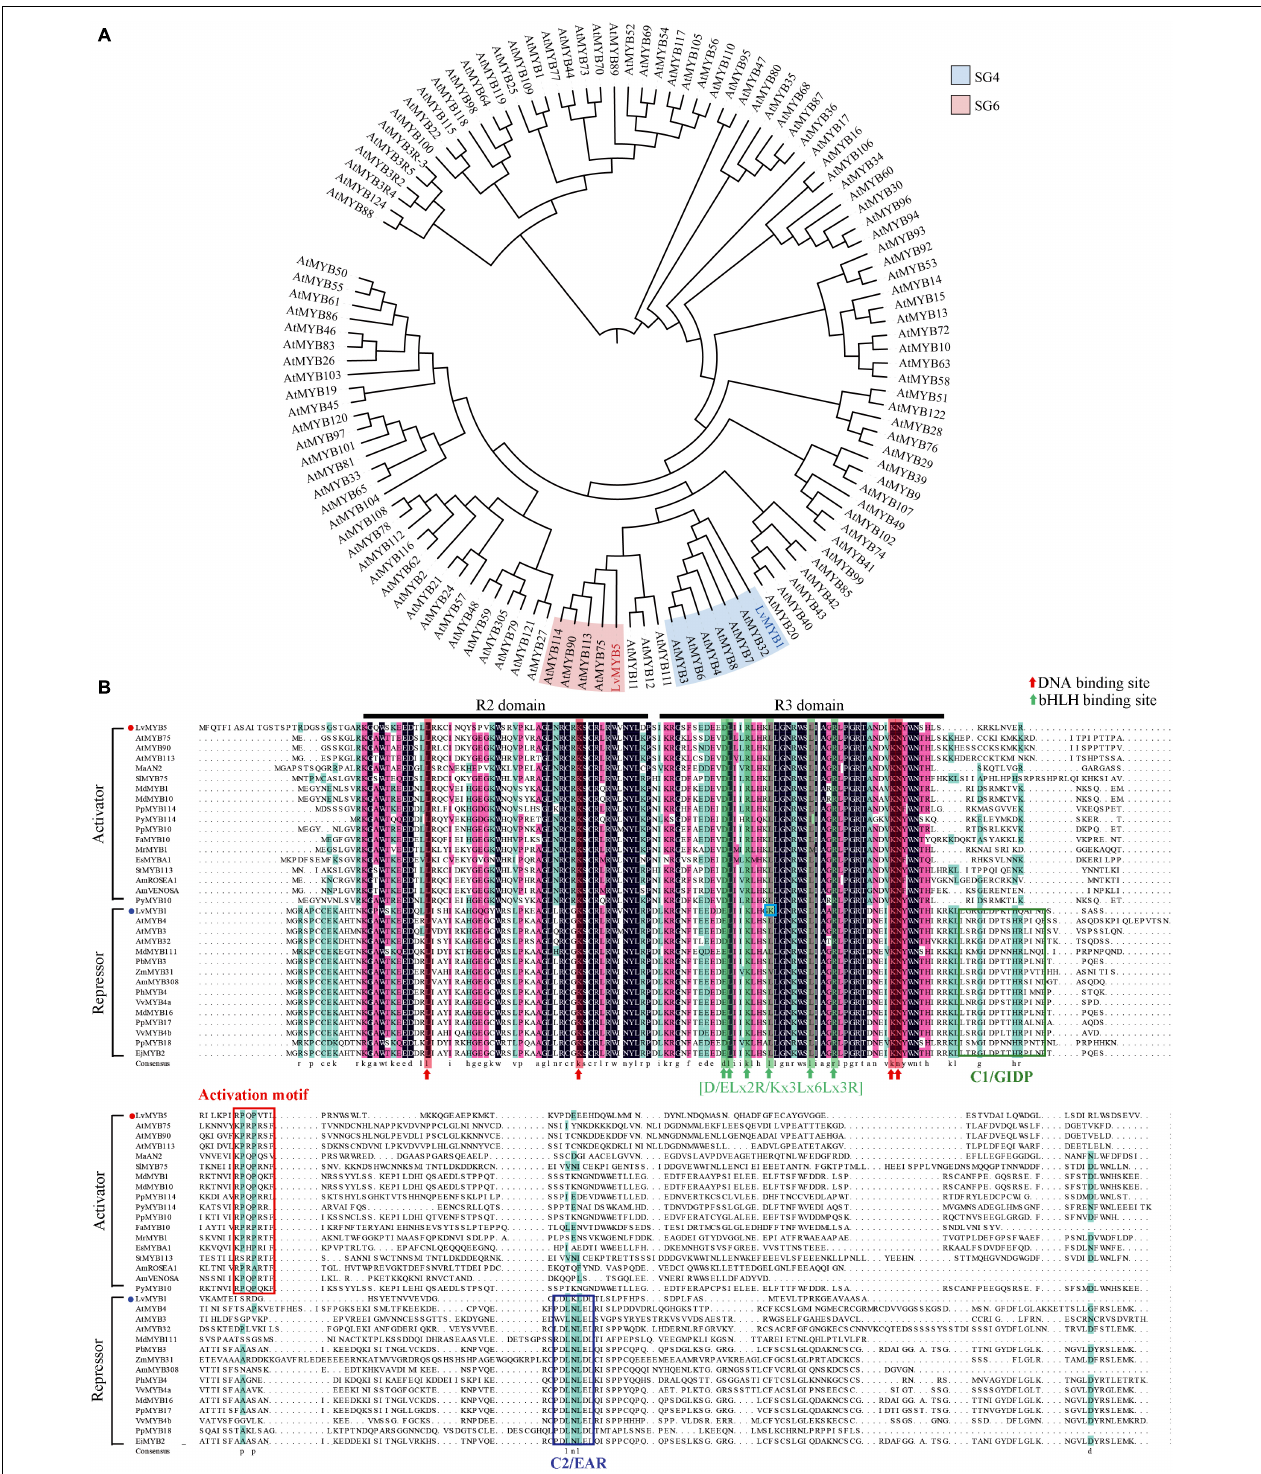
FIGURE 3 | Phylogenetic tree analysis and multi-sequence alignments of LvMYB1, LvMYB5, and other MYB TF proteins related to anthocyanin biosynthesis. (A) A phylogenetic tree showing the evolutionary relationships between LvMYB5, LvMYB1, and MYB family proteins from Arabidopsis . (B) Multi-sequence alignments of LvMYB5 and LvMYB1 with MYB activators and repressors related to anthocyanin synthesis from other plants species. Black lines: R2 and R3 domains. Red arrow: DNA binding sites. Green arrow: bHLH binding motif. Blue box: The mutation site. Red box: The activation motif. The other colored boxes: C1/GIDP and C2/EAR